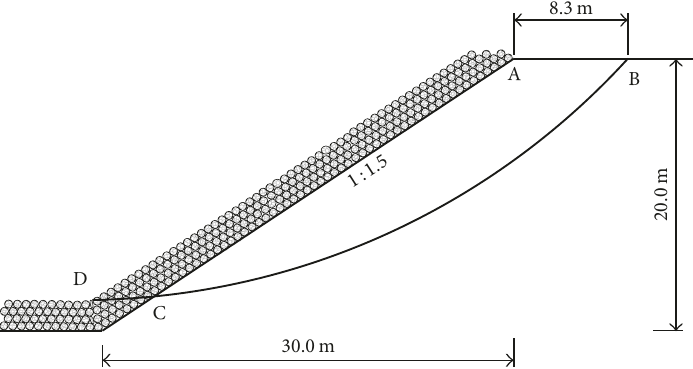
Figure 7: Schematic diagram of a slope with soil nets reinforcement.